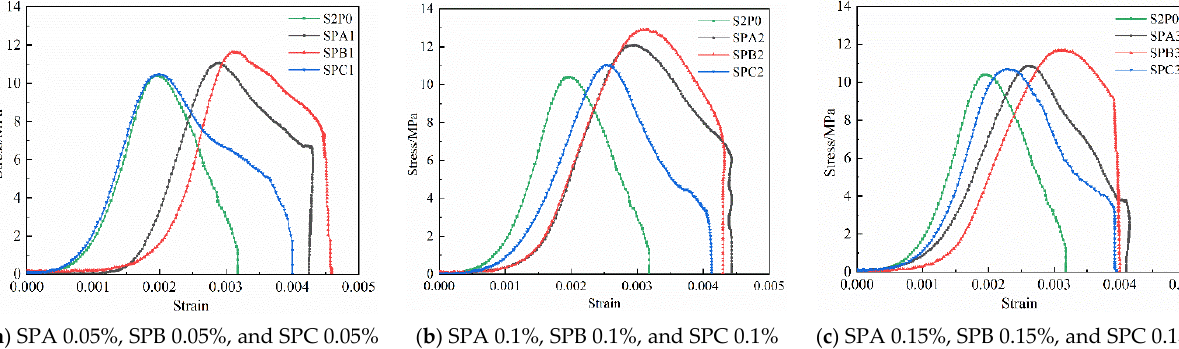
Figure 7. Splitting tensile stress–strain curve of specimens with different fiber contents at 0.2 MPa of air pressure. Table 7. SHPB dynamic split test